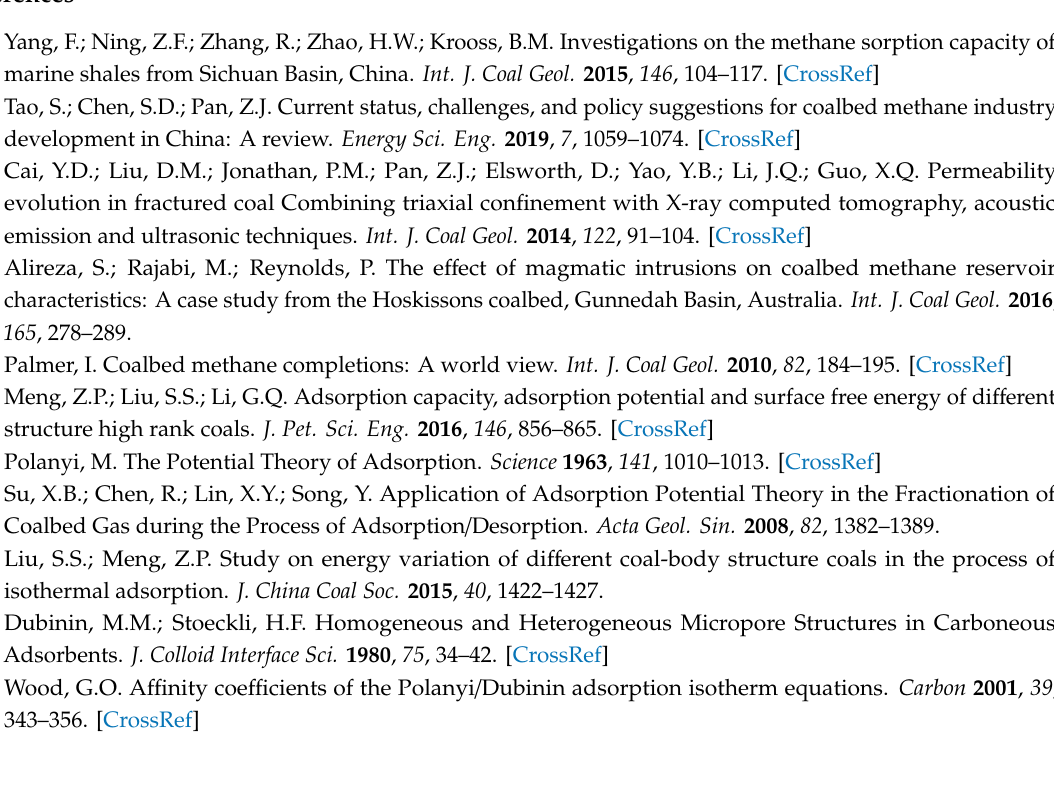
Nomenclature List Conversion for Units of